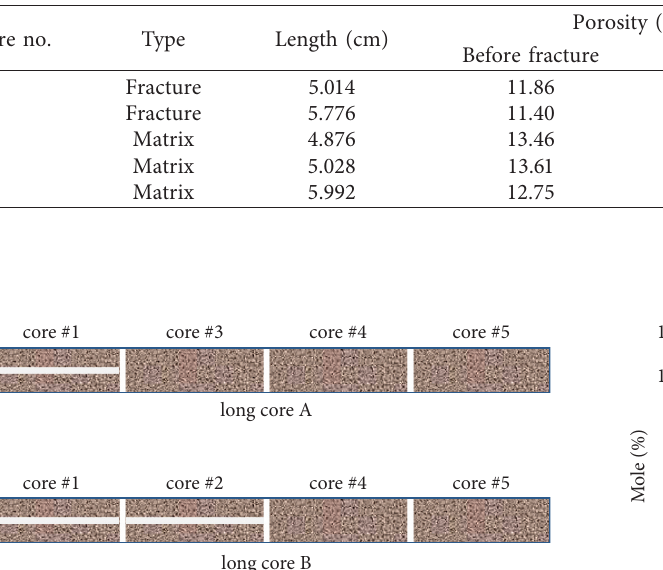
Figure 2: Artificial fractured core. Table 1: Basic properties of core samples.